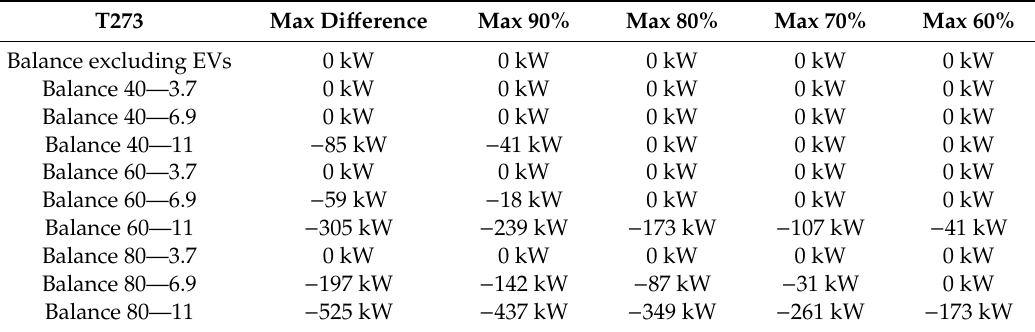
Table 14. Replacement of electric heating by district heating for transformer T273—late night